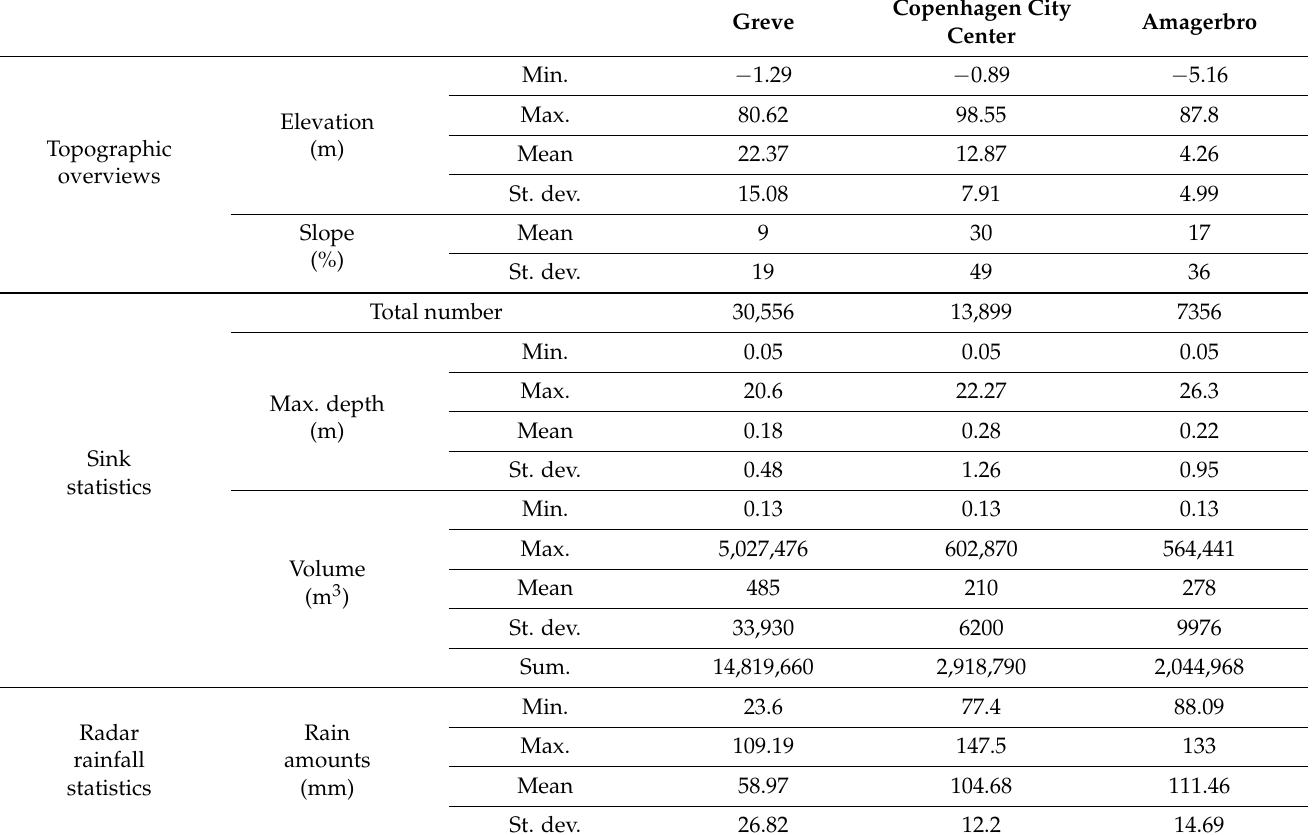
Table 1. Topographic overviews, sink statistics and radar rainfall statistics for the three case areas on 2 July 2011.